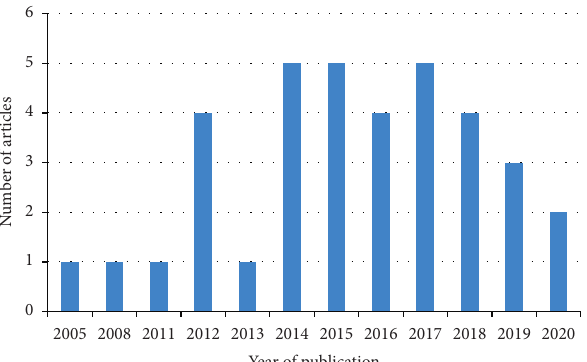
Figure 2: Number of articles under review ( n � 36) published